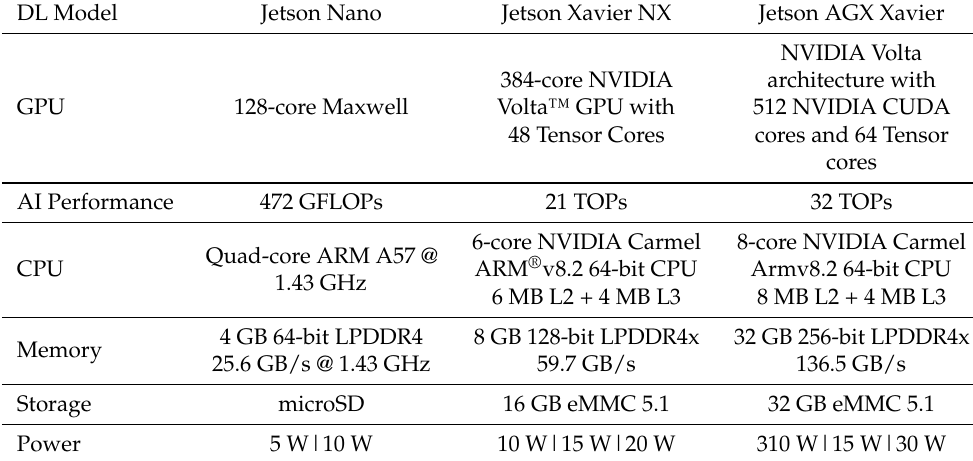
Table 3. NVIDIA GPU embedded platforms